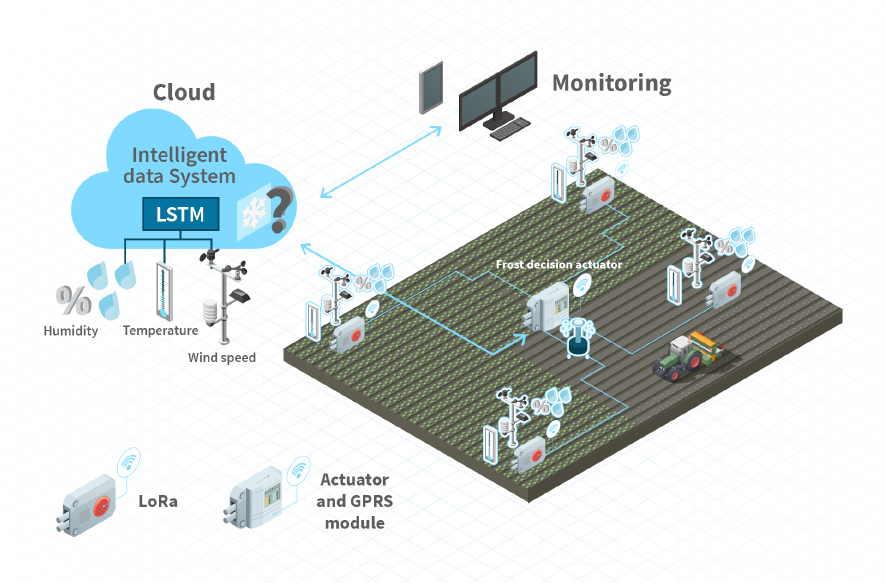
Figure 1. AIoT system